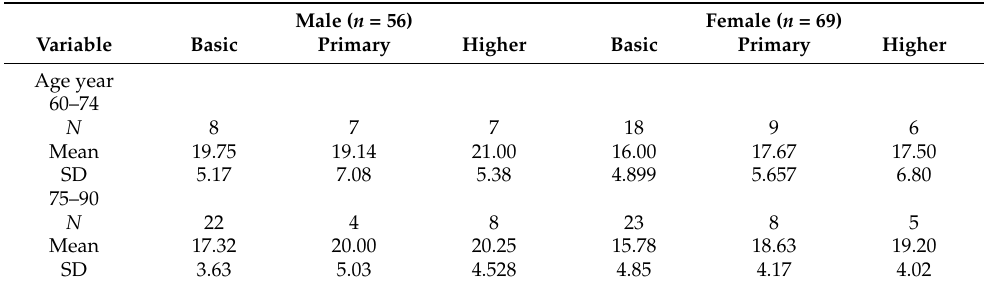
Table 2. Mean and standard deviation of MoCA by age, education level and sex in Spanish